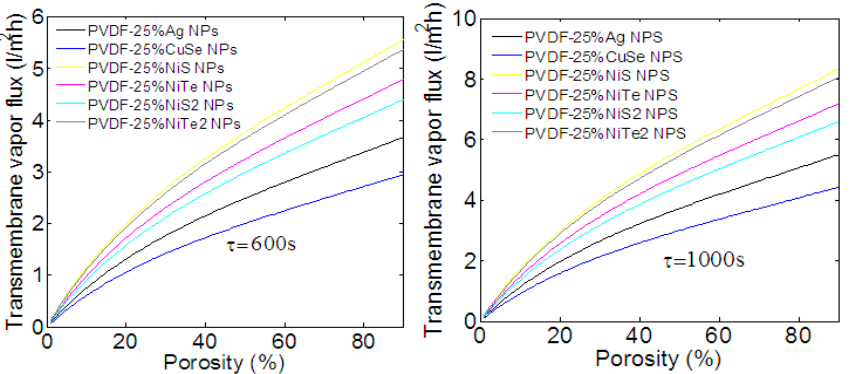
Figure 7. Transmembrane vapor flux as a function of the porosity. PVDF membrane loaded with different TMCs NPs produces between 3 and 5.5 L/m 2 h of vapor flux. These values increase to 4.2 and 8 L/m 2 h when the cooling time is about 1000 s, i.e., lower loss of heat.